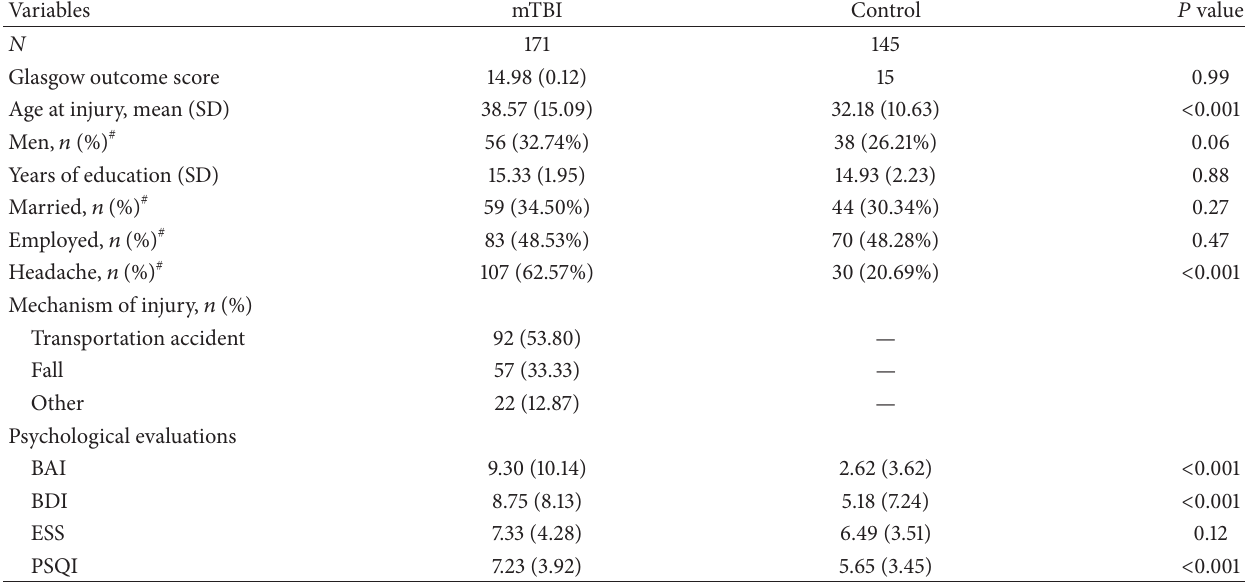
Table 1: Demographic data of the mTBI and control groups.